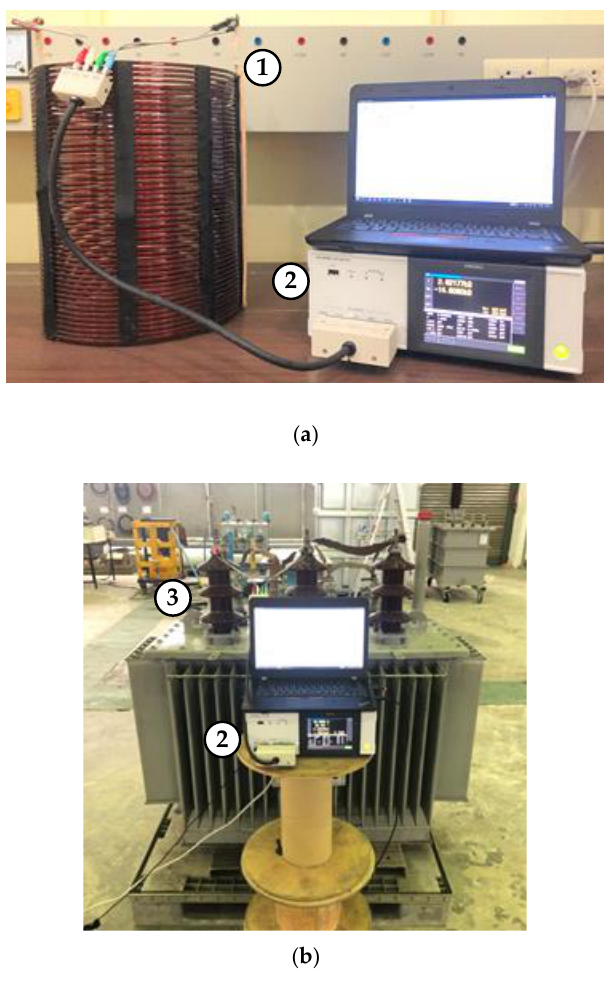
Figure 7. Experimental set up for measuring input impedance of the windings, where (1) is the winding under test, (2) is the impedance analyzer, and (3) is the transformer under test. ( a ) Reactor winding under tests. ( b ) Transformer winding under tests.